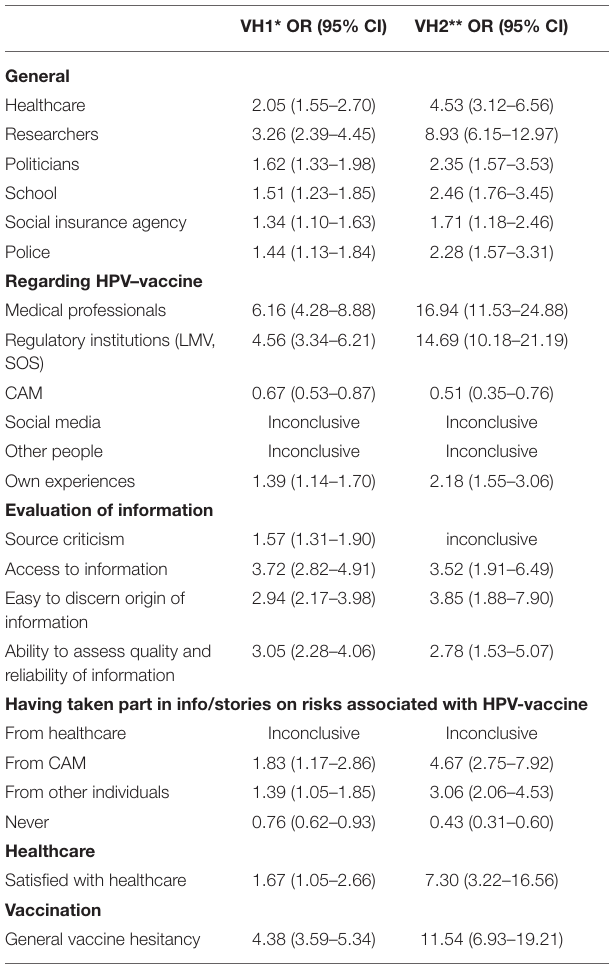
TABLE 5 | Associations between attitudes regarding information and healthcare and HPV vaccine hesitancy (VH1; VH2), expressed as odds ratios (ORs) with 95% confidence intervals